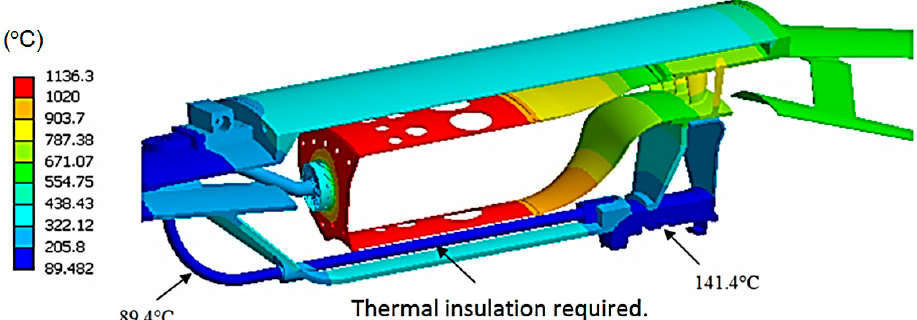
Figure 12. Temperature distribution near the combustion chamber.